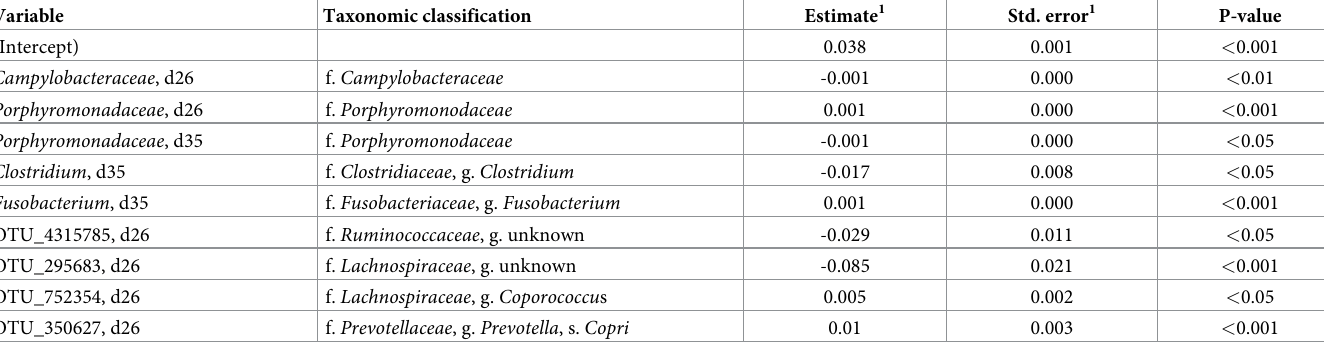
Table 4. Estimates of the parameters of the linear model calculating rADG over the d26-d48